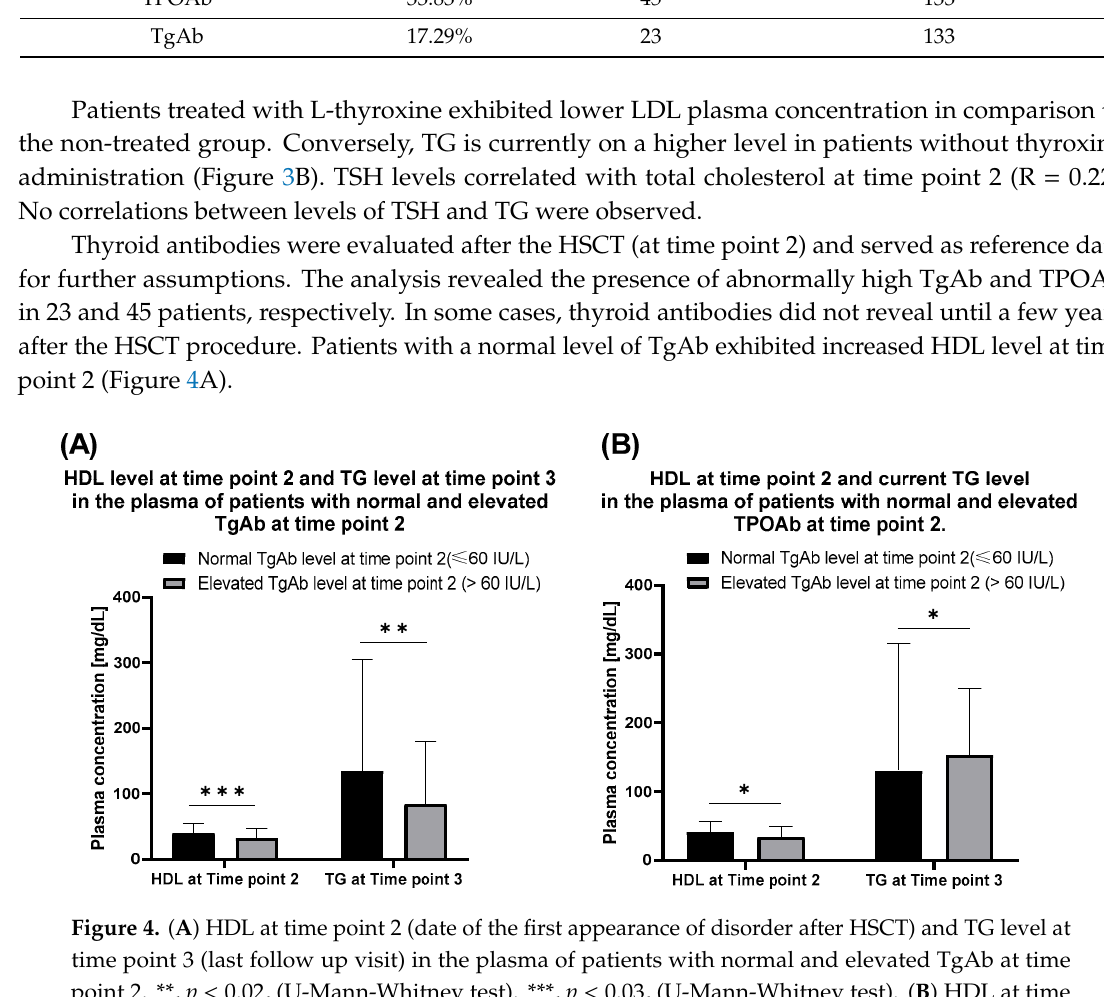
Figure 4. ( A ) HDL at time point 2 (date of the first appearance of disorder after HSCT) and TG level at time point 3 (last follow up visit) in the plasma of patients with normal and elevated TgAb at time point 2. **, p < 0.02, (U-Mann-Whitney test). ***, p < 0.03, (U-Mann-Whitney test). ( B ) HDL at time point 2 and current TG level in the plasma of patients with normal and elevated TPOAb after HSCT (time point 2). *, p < 0.01, (U-Mann-Whitney test).